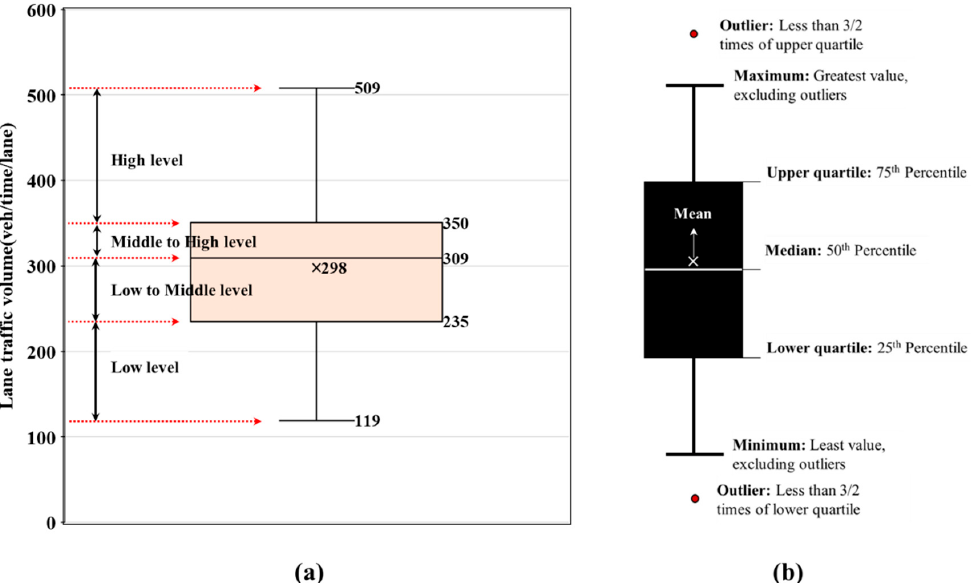
Figure 11. ( a ) Lane traffic level type classification considering lane traffic volume data distribution; ( b ) definition of boxplot used in this study.